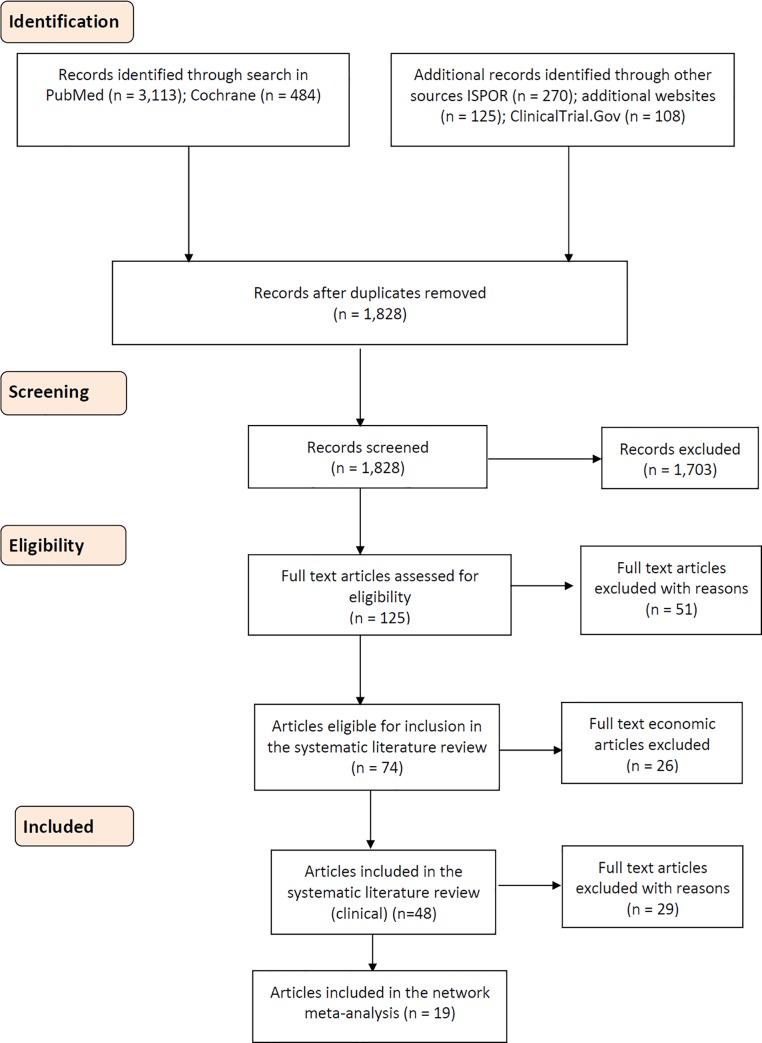
PRISMA flow diagram with the clinical studies identified through the predefined search strategy.